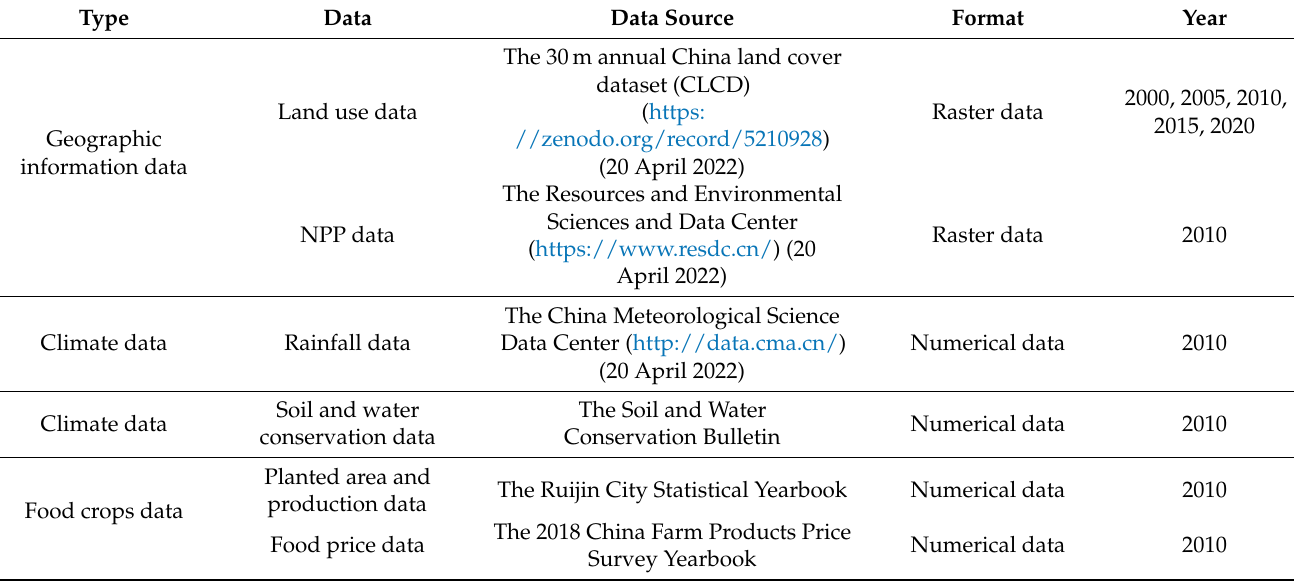
Table 1. Data sources.